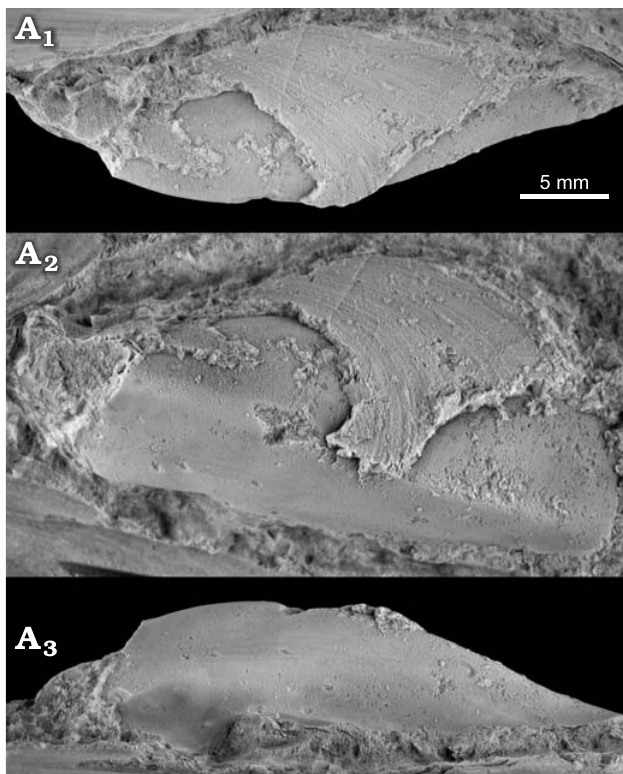
Fig. 6. The kalenterid bivalve Kasimlara sp. from the late Carnian, Late Triassic Terziler II seep deposit in southern Turkey. Mo184065, single left valve; view on the dorsal (A 1 ) and the ventral (A 3 ) sides, lateral view (A 2 ).